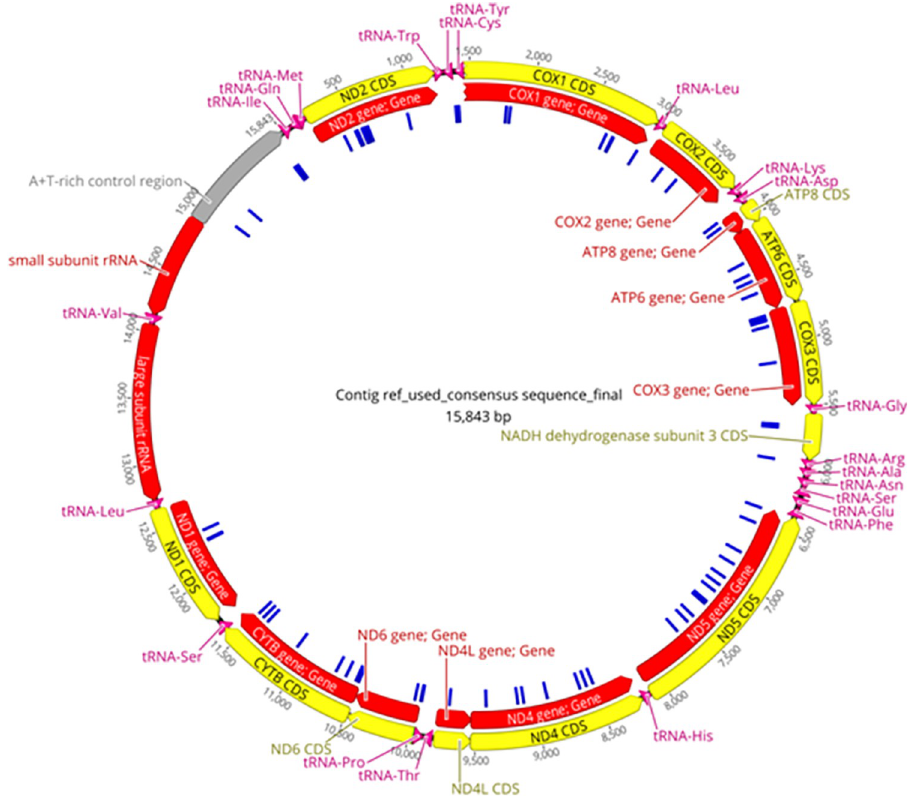
Fig 3. The complete mitochondrial genome of Aedes koreicus isolated from Hungary. Reads generated with Oxford Nanopore and Illumina sequencing techniques were mapped to the mitochondrial genome with accession number MT093832 with Minimap v.2.17. Gene annotation and visualization were performed in Geneious Prime 2021.1. The yellow circle represents the coding sequence (CDS) or gene product, the red circle represents the sequence of the complete gene, whilst the blue marks in the inner circle represent the single nucleotide differences (n = 74) between the genomes of Ae . koreicus isolated from Hungary and